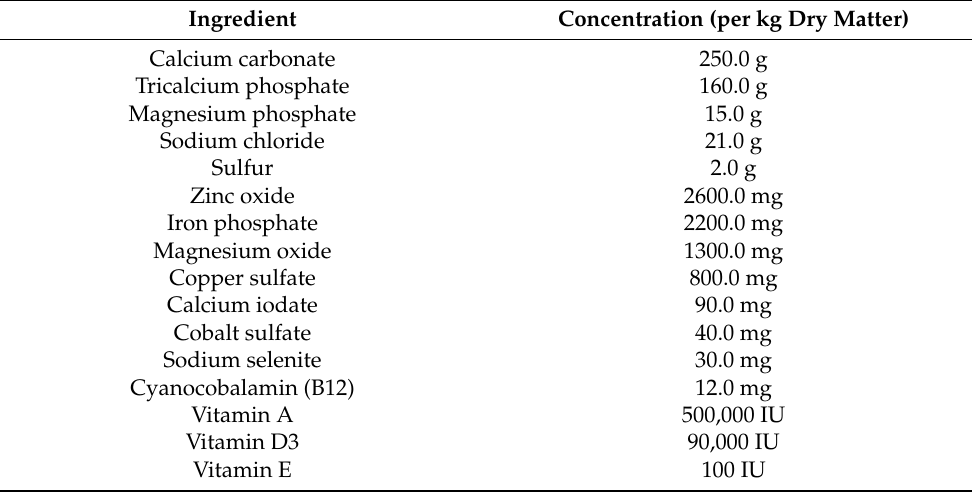
Table 1. Composition of the multi-vitamin supplement Engorvisal Leche© fed to lactating Brown Swiss cows grazing a mixed alfalfa-ryegrass sward and supplemented with a corn- or an oat-based concentrate mixture before or after